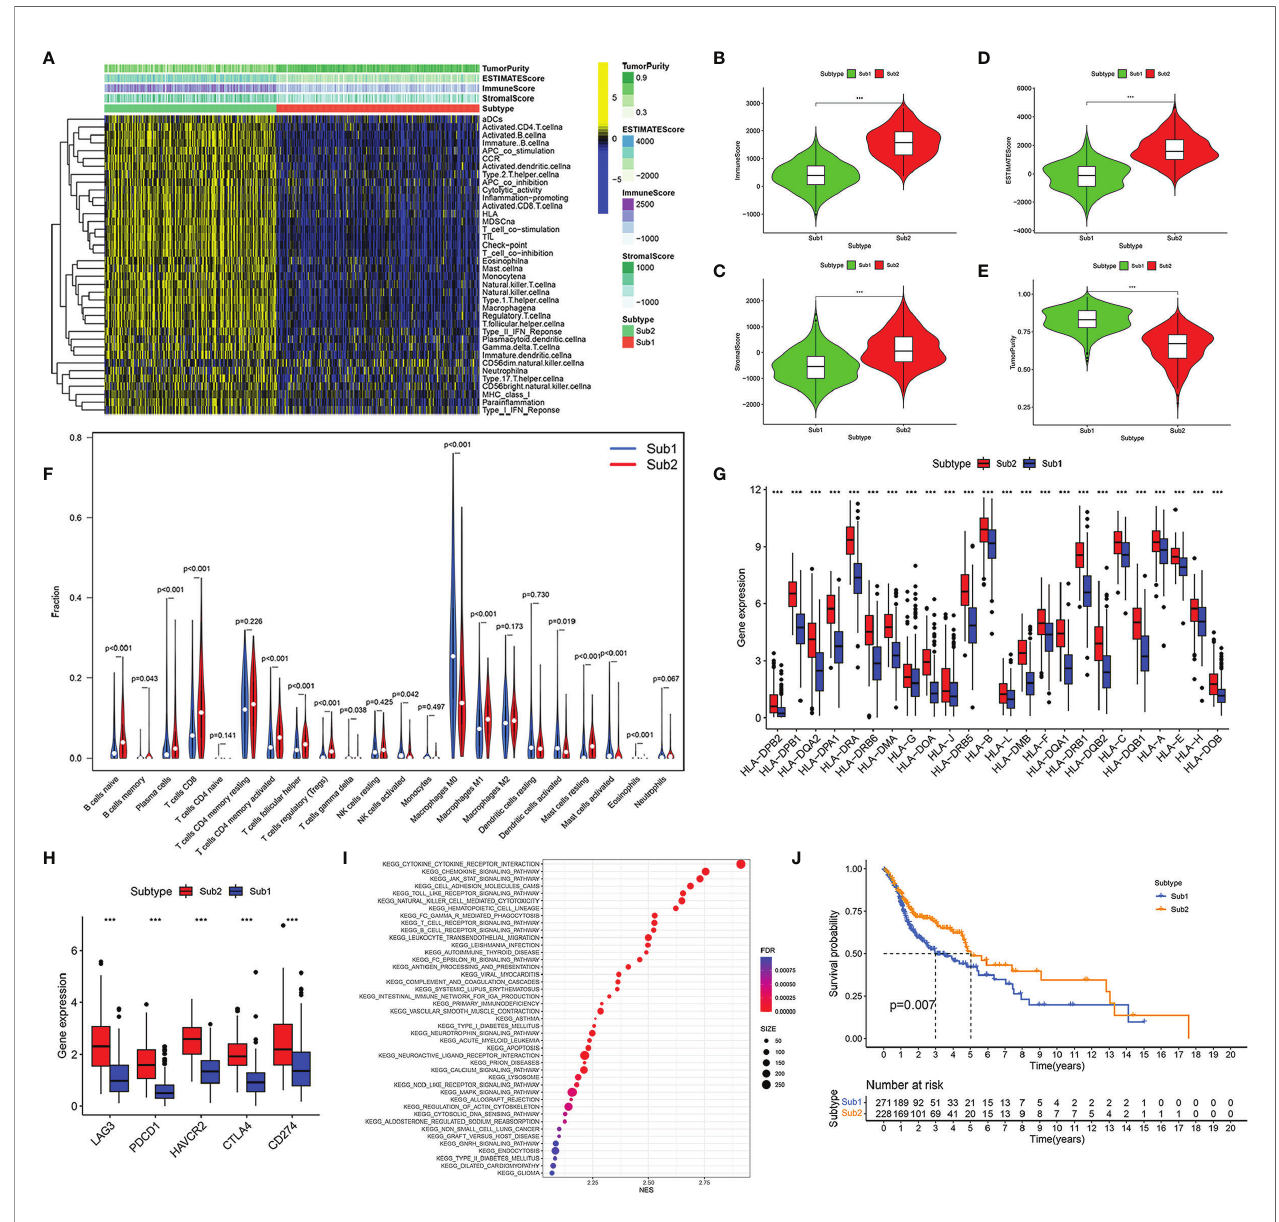
FIGURE 2 | Immune subtypes of head and neck squamous cell carcinoma (HNSCC) were identi fi ed based on the tumor-in fi ltrating immune cells. Heatmap of single-sample gene set enrichment analysis (ssGSEA) scores for Sub1 group (n = 271) and Sub2 group (n = 228) (A) . Comparison of immune score (B) , stromal score (C) , ESTIMATE score (D) , and tumor purity (E) between Sub1 and Sub2 groups. Difference of immune cell in fi ltration between Sub1 and Sub2 groups (F) . The expressions of HLA family genes in Sub1 and Sub2 groups (G) . The discrepancy of immune checkpoint genes between Sub1 and Sub2 groups, including LAG3, PDCD1, HAVCR2, CTLA4, and CD274 (H) . The divergence of enrichment pathways between Sub1 and Sub2 groups (I) . Kaplan – Meier curves of Sub1 and Sub2 groups (J) . ***p <